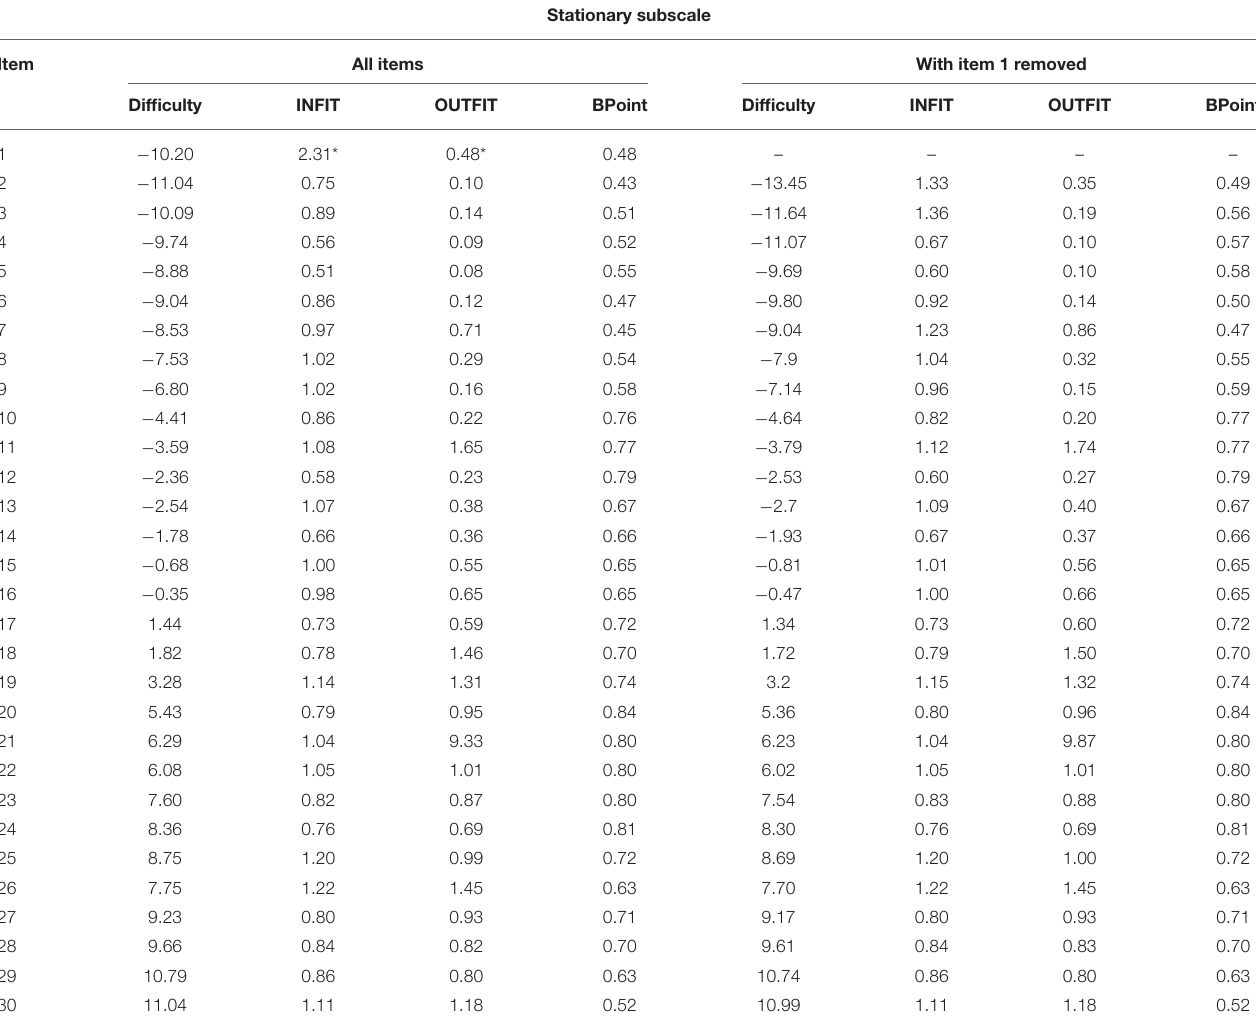
TABLE 3 | Stationary subscale: item difficulty, INFIT, OUTFIT, and point-biserial correlations before and after removing